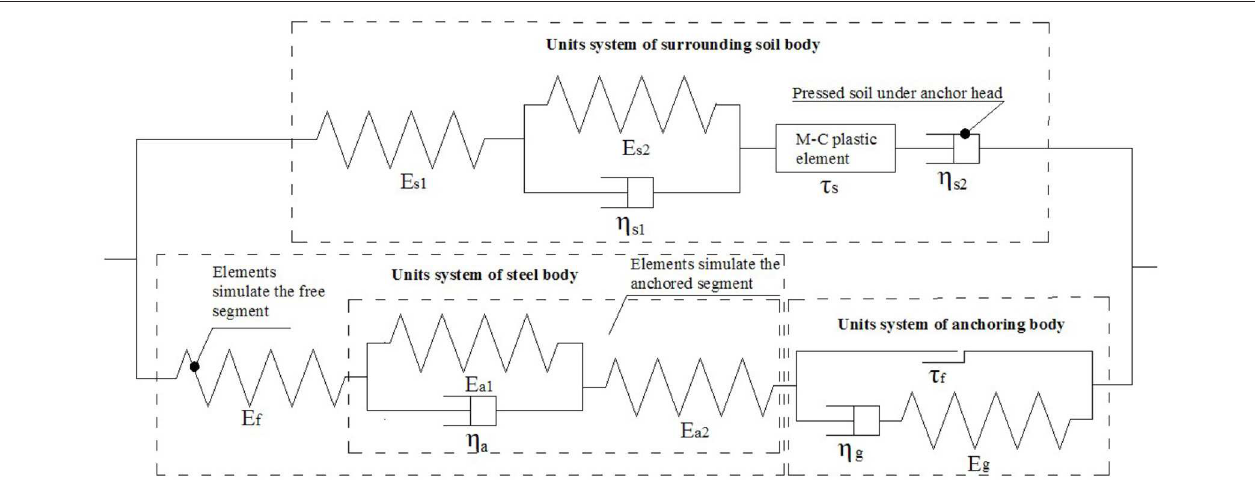
FIGURE 3 | Creep model of the anchor structure: E s 1 , E s 2 , η s 1 , η s 2 , and τ s are the elastic modulus, the viscoelastic modulus, the viscoelastic coefficient, the viscosity coefficient, and the shear strength of the soil, respectively; E f is the elastic modulus of the free segment; E a 1 , E a 2 , and η a are the viscoelastic modulus, the viscoelastic coefficient, and the viscosity coefficient of the anchored segment; E g , η g , and τ f are the elastic modulus, the viscoelastic modulus, and the shear strength of the